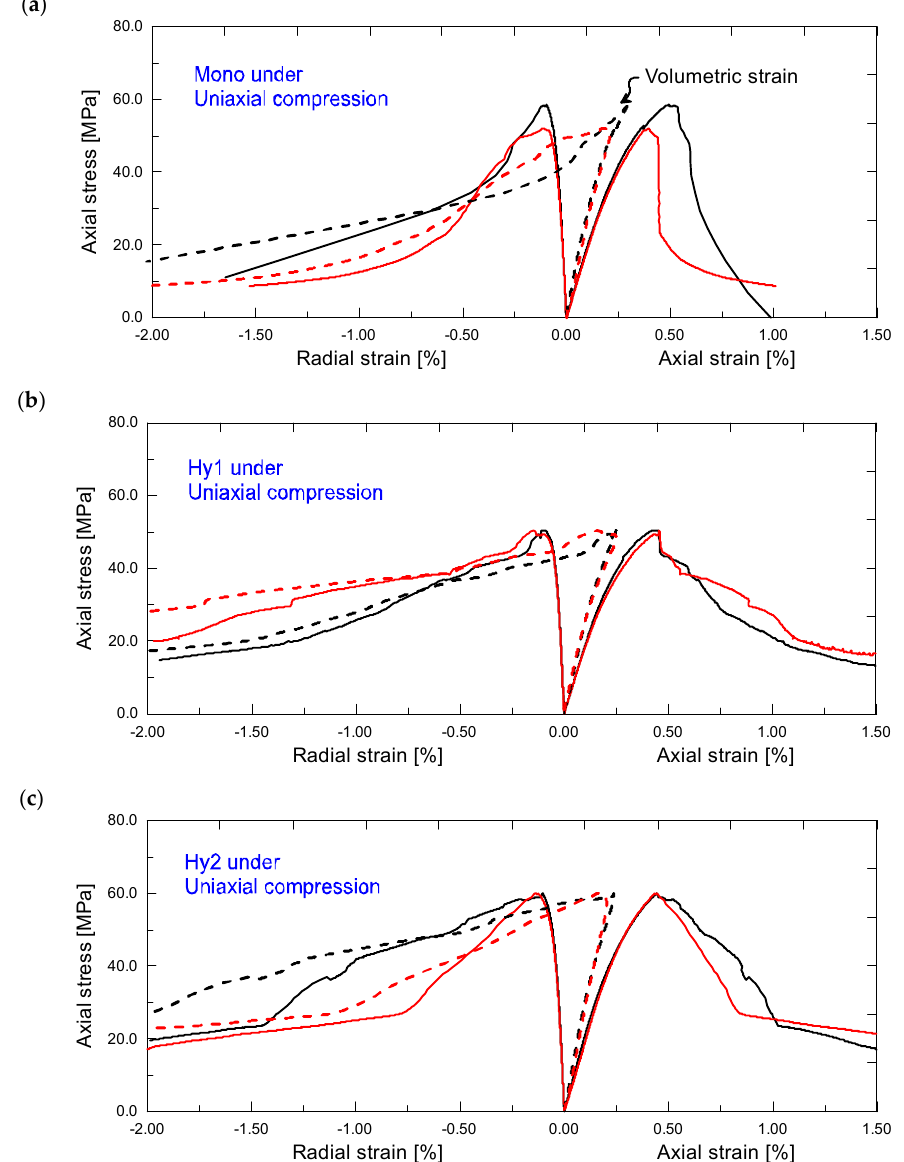
Figure 3. Stress–strain relations of ( a ) Mono, ( b ) Hy1 and ( c ) Hy2 mixtures under uniaxial compression.